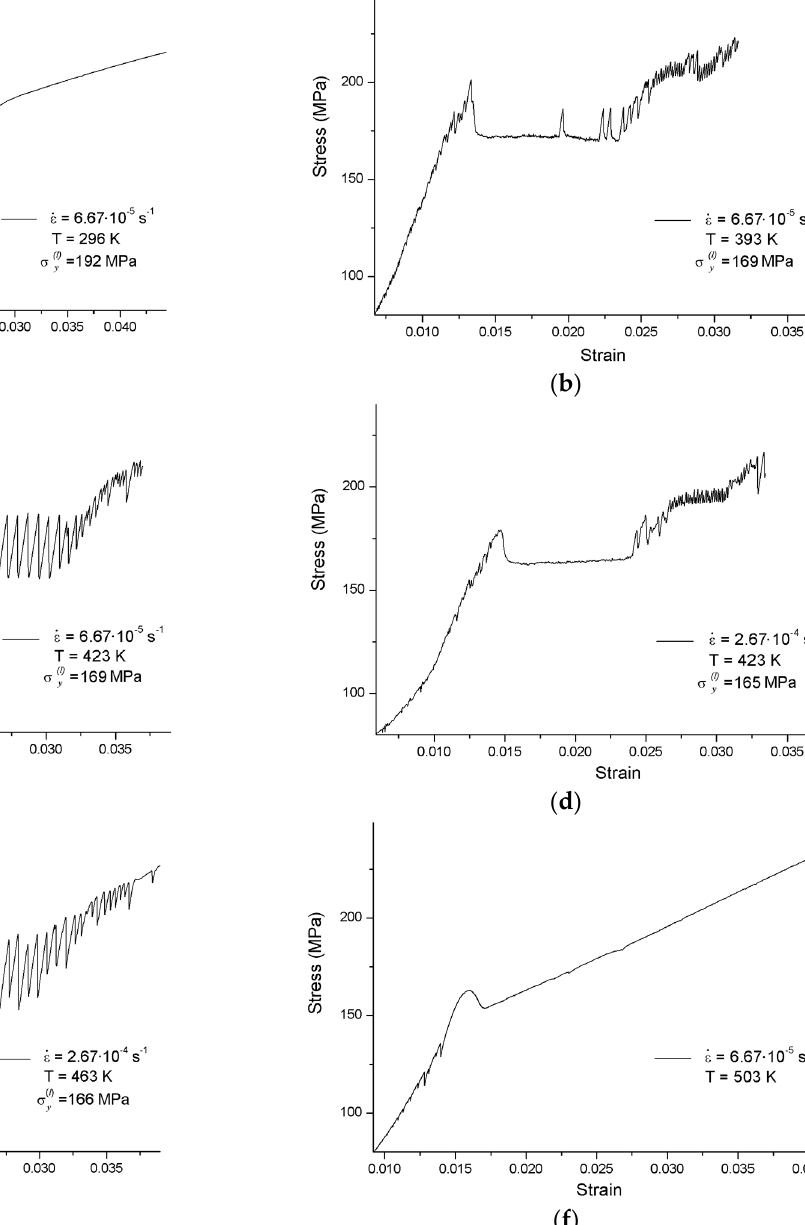
Figure 1. Loading curve at T = 296 K, 𝜀(cid:4662) = 6.67·10 − 5 s − 1 ( a ); T = 393 K, 𝜀(cid:4662) = 6.67·10 − 5 s − 1 ( b ); T = 423 K, 𝜀(cid:4662) = 6.67·10 − 5 s − 1 ( c ); T = 423 K, 𝜀(cid:4662) = 2.67·10 − 4 s − 1 ( d ); T = 463 K, 𝜀(cid:4662) = 2.67·10 − 4 s − 1 ( e ); T = 503 K, 𝜀(cid:4662) = 6.67·10 − 5 s − 1 ( f ).